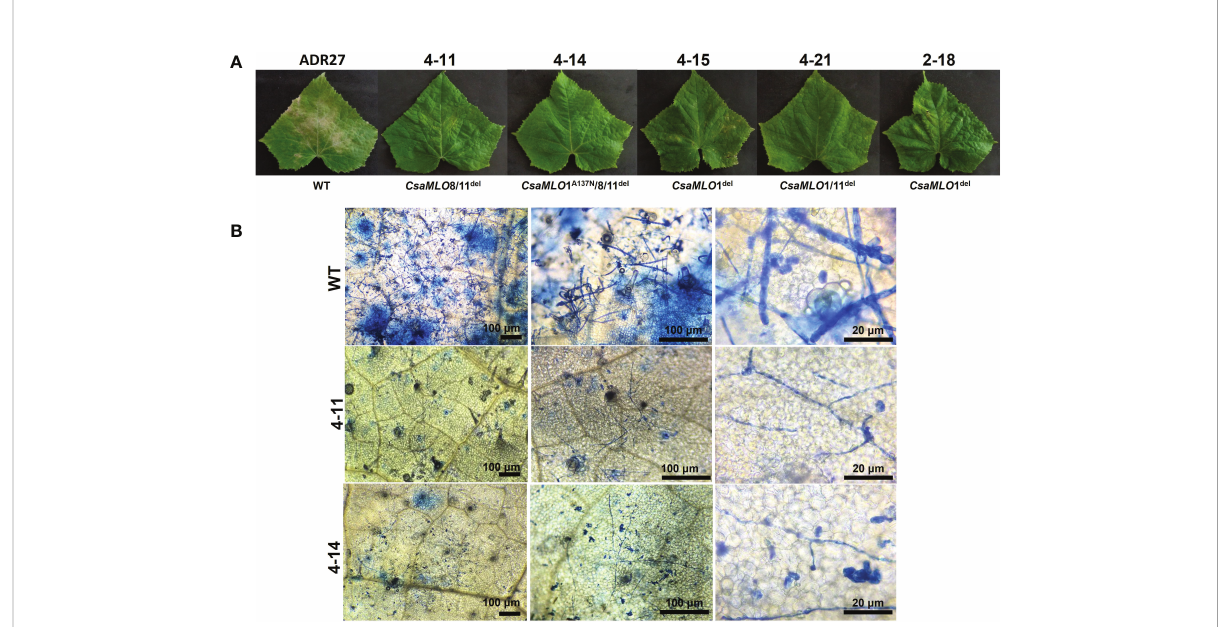
FIGURE 5 Powdery mildew symptoms and visualization of P. xanthii spores on WT/mutant leaves using Trypan Blue. (A) Powdery mildew symptoms on leaf surfaces of WT-ADR27 and CsaMLO mutants at 10 dpi. Typical symptoms could be seen on the WT leaves as a result massive propagation caused by P. xanthii after ten-days post inoculation. Restricted symptoms were detected on P. xanthii inoculated leaves of 4-15, 4-21, and 2-18 plants. Moreover, the hypersensitive response associated lesions were apparent on the leaves of CsaMLO1 del and CsaMLO1 /11 del plants. However, no symptoms appeared on the leaves of 4-11 and 4-14 plants after ten days of inoculation. (B) The epidermal surface of WT-ADR27 was covered with P. xanthii conidiophore and conidiospores that was newly formed from inoculated spores. Also, massive cell deaths were observed on the leaf mesophyll as a result of pathogen activity apparent from the blue color. However only mycelial growth was detected on the leaves of 4-11 and 4-14 plants, even if there was restricted germination